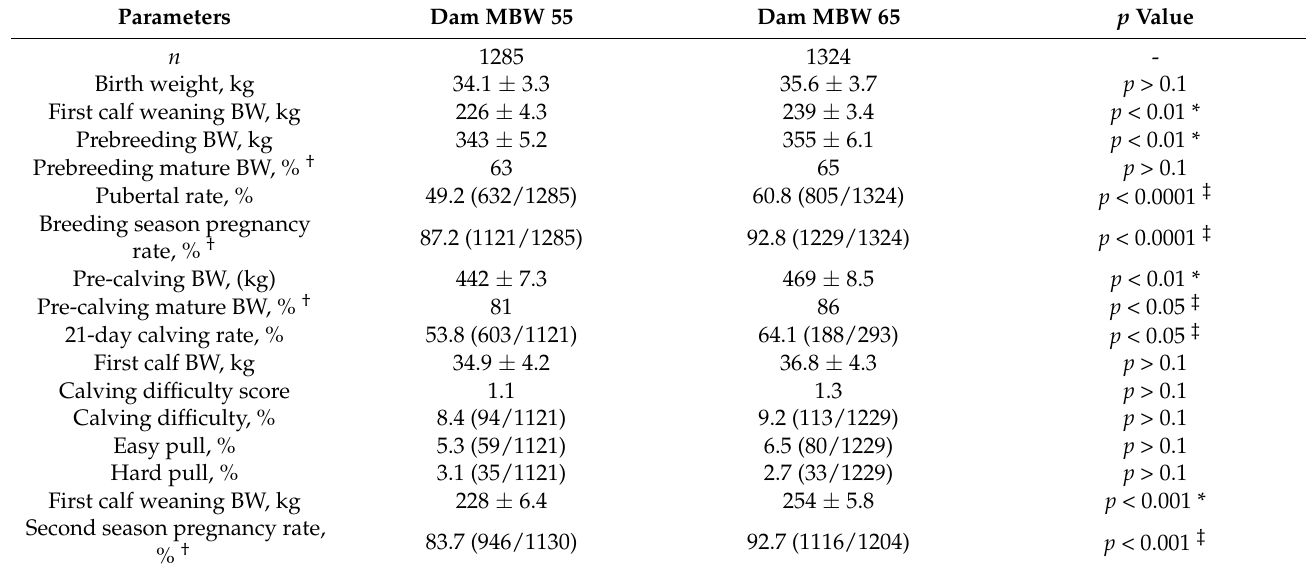
Table 2. Performance of first-generation replacement heifers born to dams with 55% vs. 65% mature body weight (BW) at